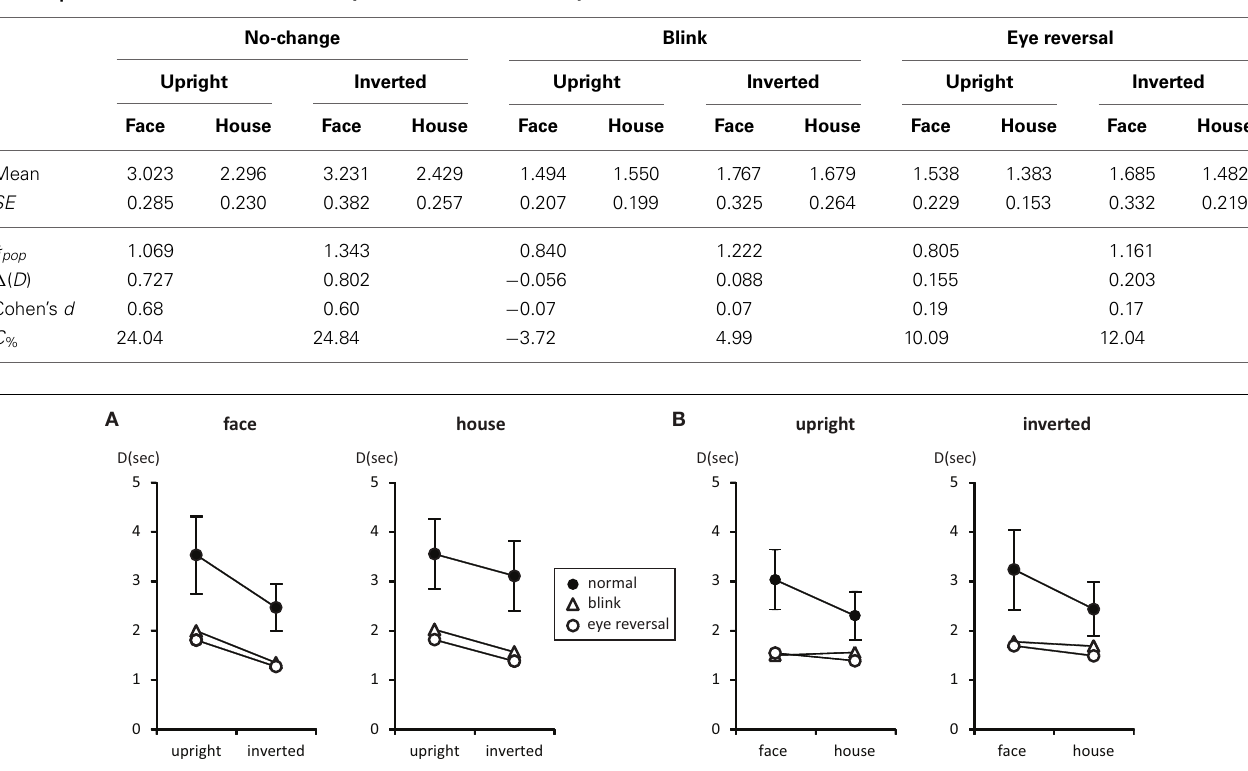
FIGURE 3 | Mean durations of dominance epochs (seconds) for upright faces and houses rivaling against their inverted counterparts (A), and faces rivaling against houses (B). Error bars indicate 95% confidence limits of the